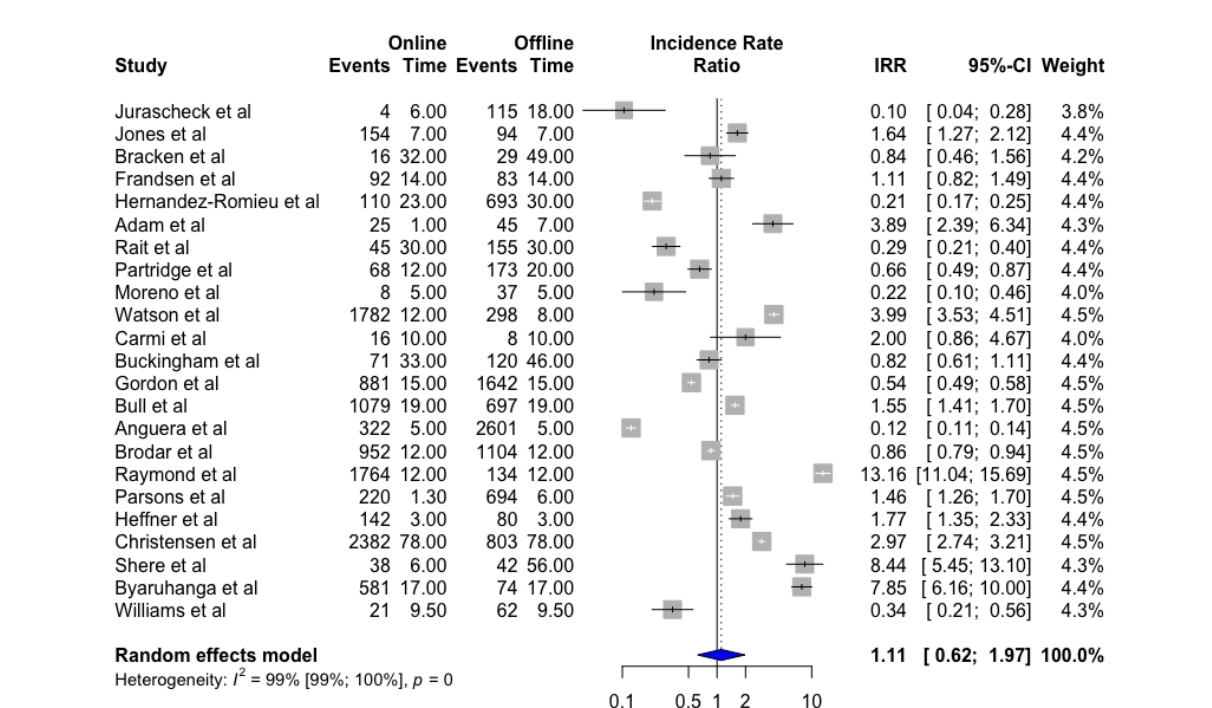
Figure 3. Recruitment rate for the entire period of recruitment online and offline in months. Value <1, in favor of offline recruitment; value >1, in favor of online recruitment.